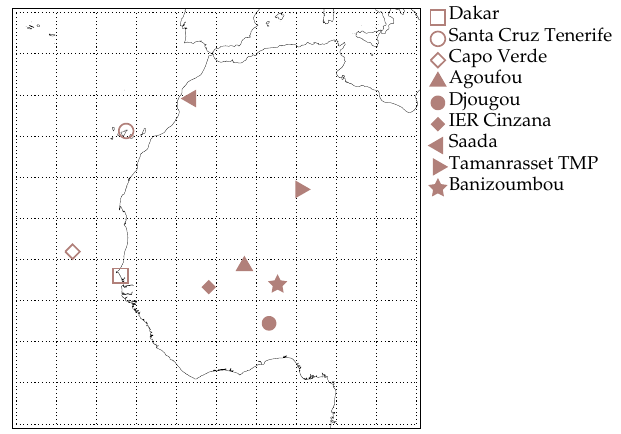
Fig. 3. Location and symbol of the AERONET sites. Every site has a different symbol, consistent with the following AERONET plots: open for coast sites, closed for land sites.